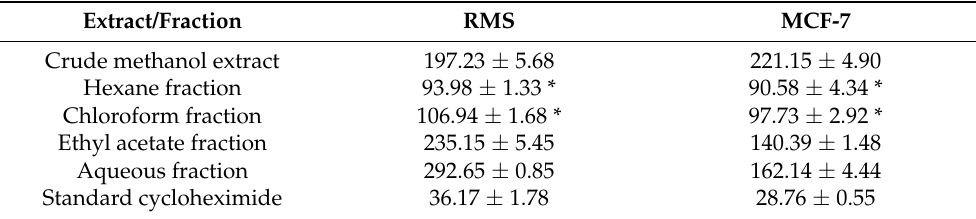
Table 2. Cytotoxic activity (IC 50 ) of human RMS and MCF-7 cells treated with the methanol extract of C. minima and different fractions compared to the standard, as determined by the MTT assay.